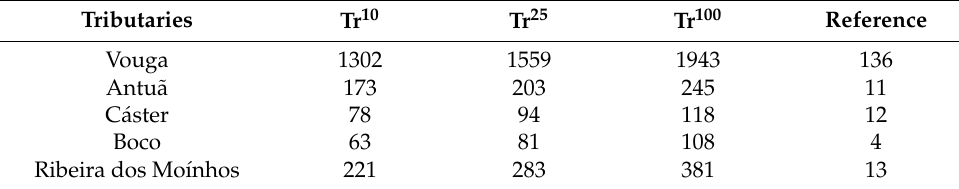
Table 2. River discharges (m 3 /s) for reference, and 10-, 25-, and 100-years return periods. Tributaries Tr 10 Tr 25 Tr 100 Reference Vouga 1302 1559 1943 Antu ã 173